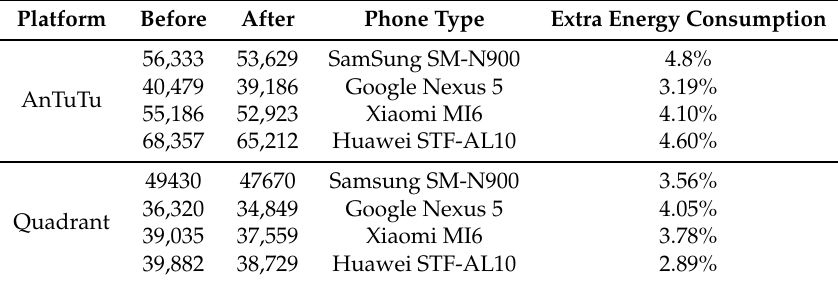
Table 4. System performance.